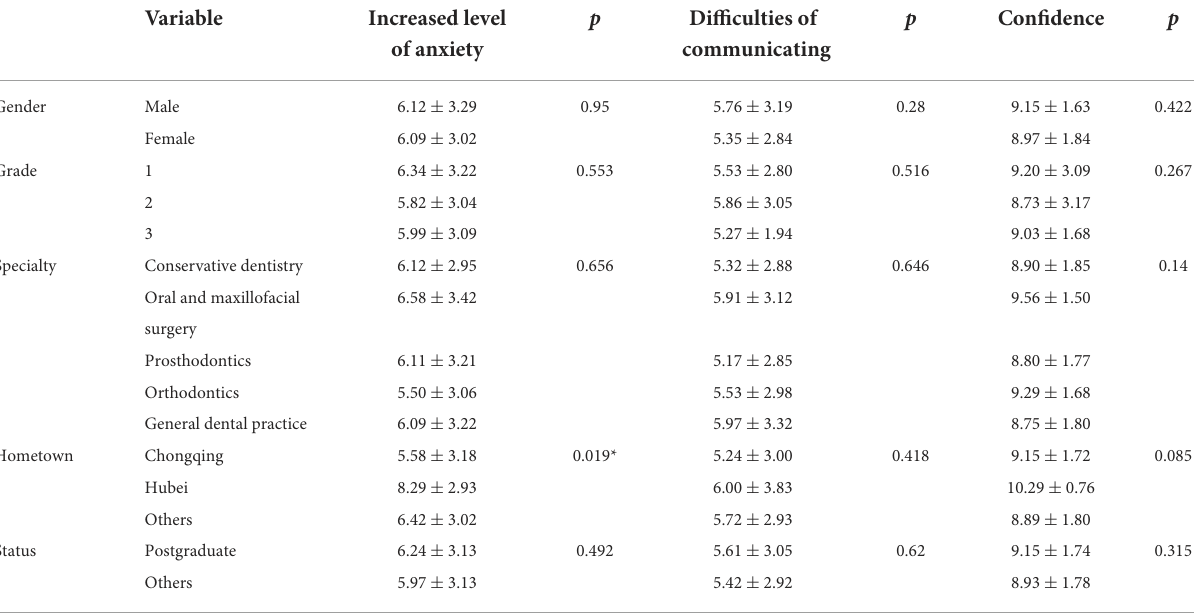
TABLE 5 Impact of COVID-19 on increased anxiety, difficulties of communicating, and confidence of facing with the public health emergency. p Difficulties of p Confidence Variable Increased level of anxiety communicating